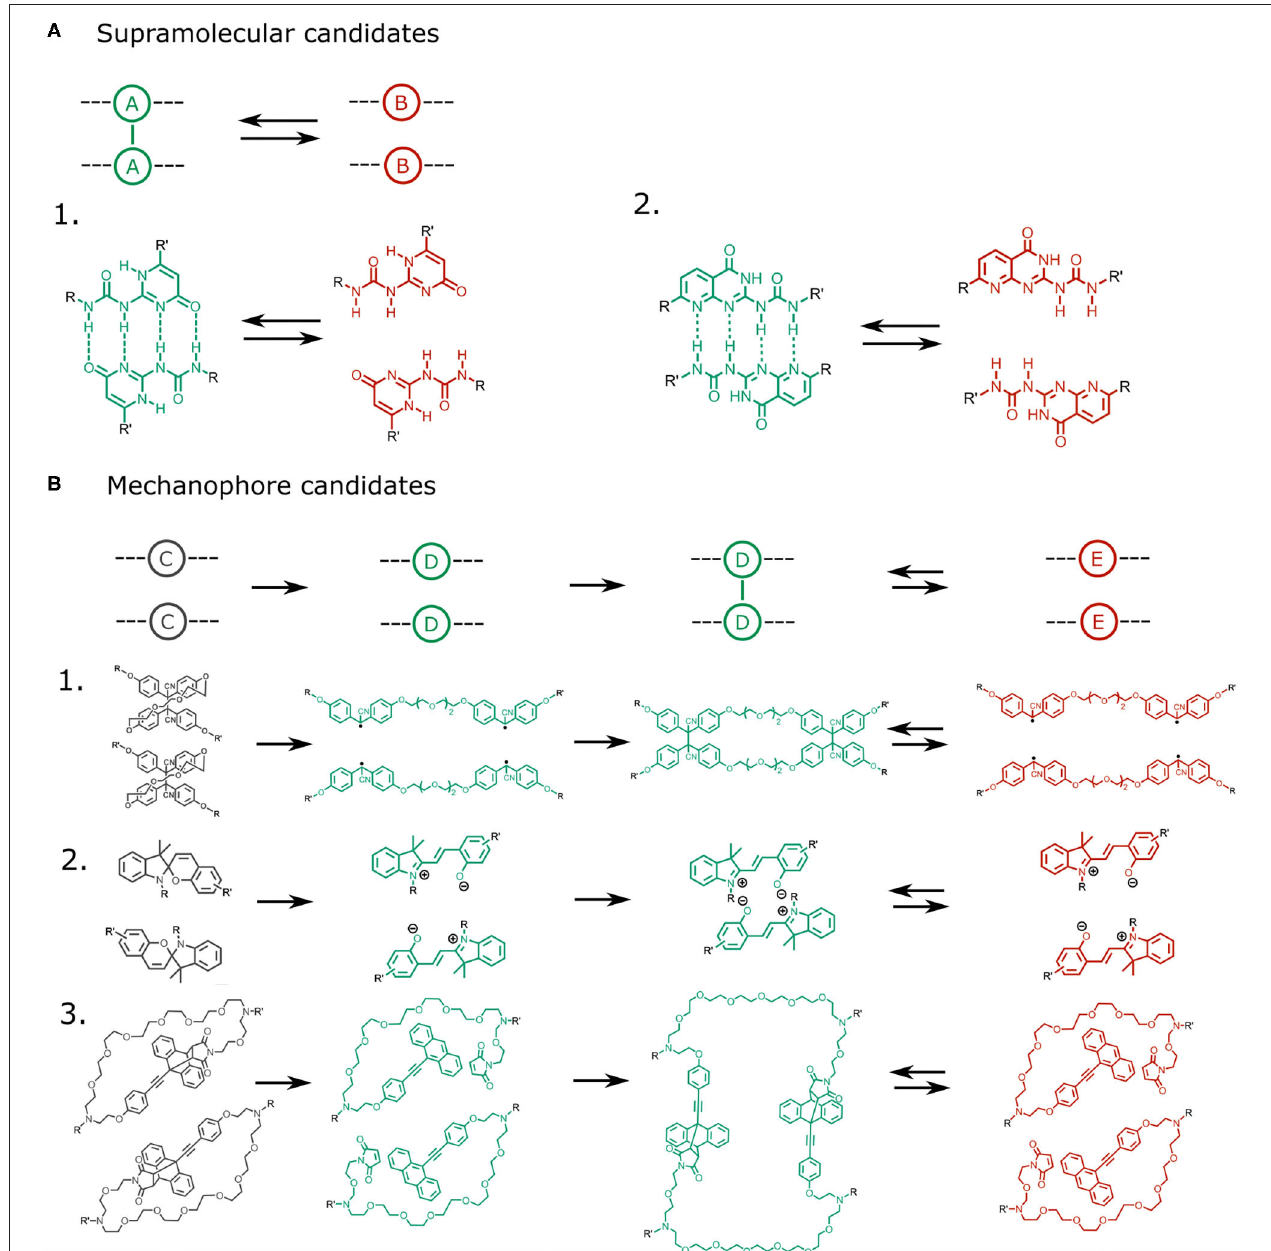
FIGURE 5 | (A) Potential quadruple hydrogen bonding candidates for the supramolecular interaction A − A . Two examples based on 2-ureido-4[1H]-pyrimidone are shown [24, 25]. (B) Potential mechanophore candidates should be capable of converting an intramolecular bond ( C ) into an intermolecular bond ( D − D ). Hypothetical examples are: 1. a bridged tetraphenyl succinonitrile molecule containing a reversibly cleavable C-C bond [26, 27], 2. spiropyran, which converts into zwitterionic merocyanine after rupture of an intramolecular C-C bond, allowing it to dimerize through electrostatic interactions and π − π stacking [28–31], and 3. Diels-Alder adducts, which can dissociate through a mechanically induced retro-Diels-Alder reaction, and subsequently reassociate to form intermolecular Diels-Alder bonds